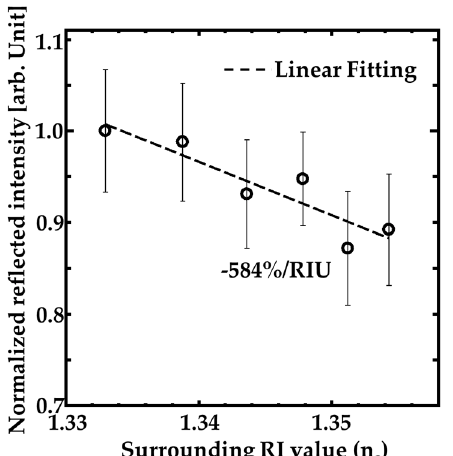
Figure 7. Dependence of the reflection peak intensity at the wavelength of 405 nm on the surrounded RI value around the HCG.